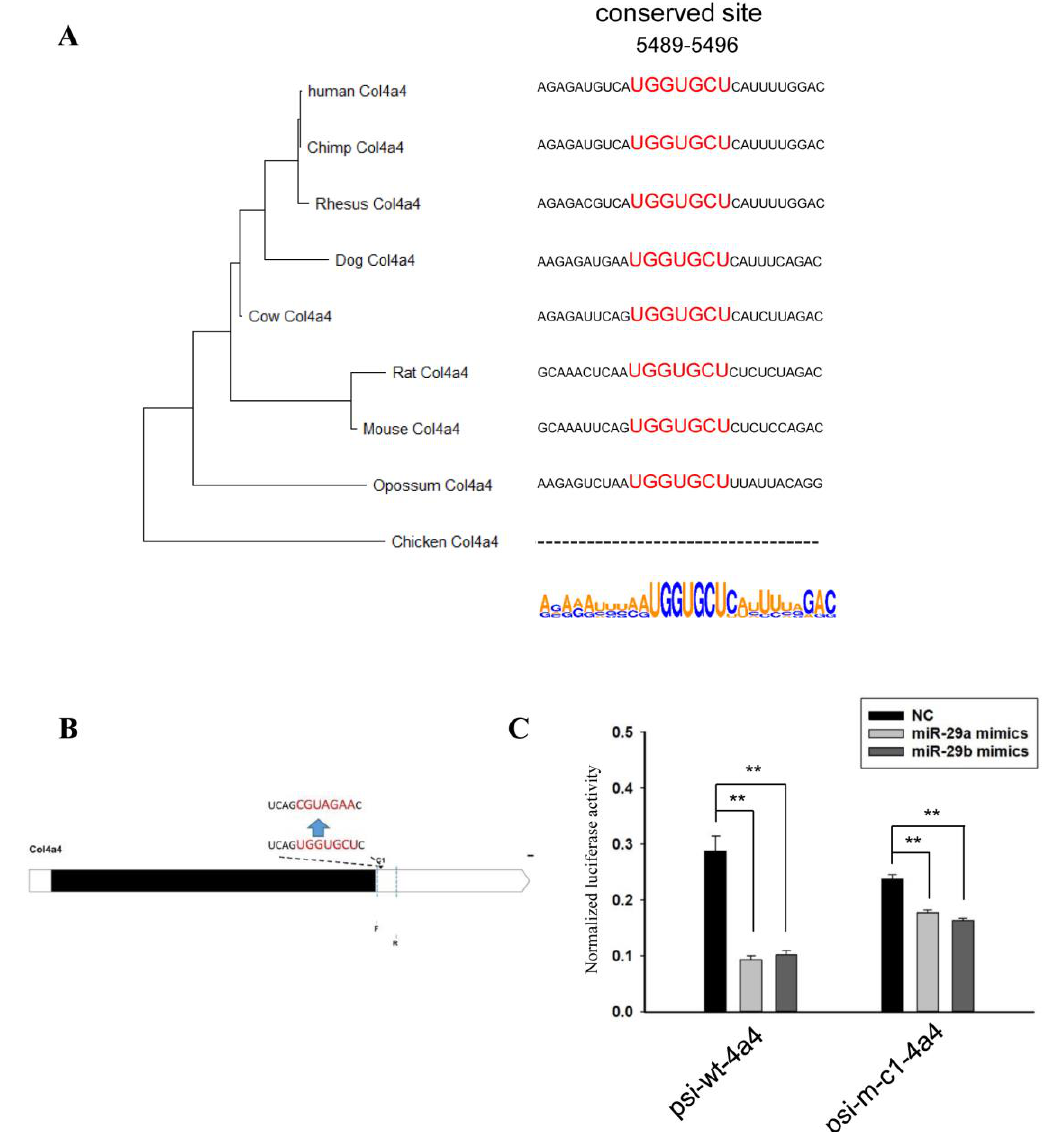
Figure 4. MiR-29 directly regulated the 3 ’ UTR of Col4a4 . ( A ) Phylogenetic tree constructed from the 3 ’ UTRs of Col4a4 in multiple species. Analysis of miR-29 binding sites and flanking sequences in the 3 ’ UTRs of Col4a3 in multiple species. ( B ) Schematic diagram of complementary sequence site and primer sites. ( C ) The effect of miR-29a or miR-29b mimics on the relative luciferase activity of the psi-wt-4a4 vector and psi-m-c1-4a4 vector was examined. The data are shown as the mean ± SEM ( n = 3). **, p < 0.01.